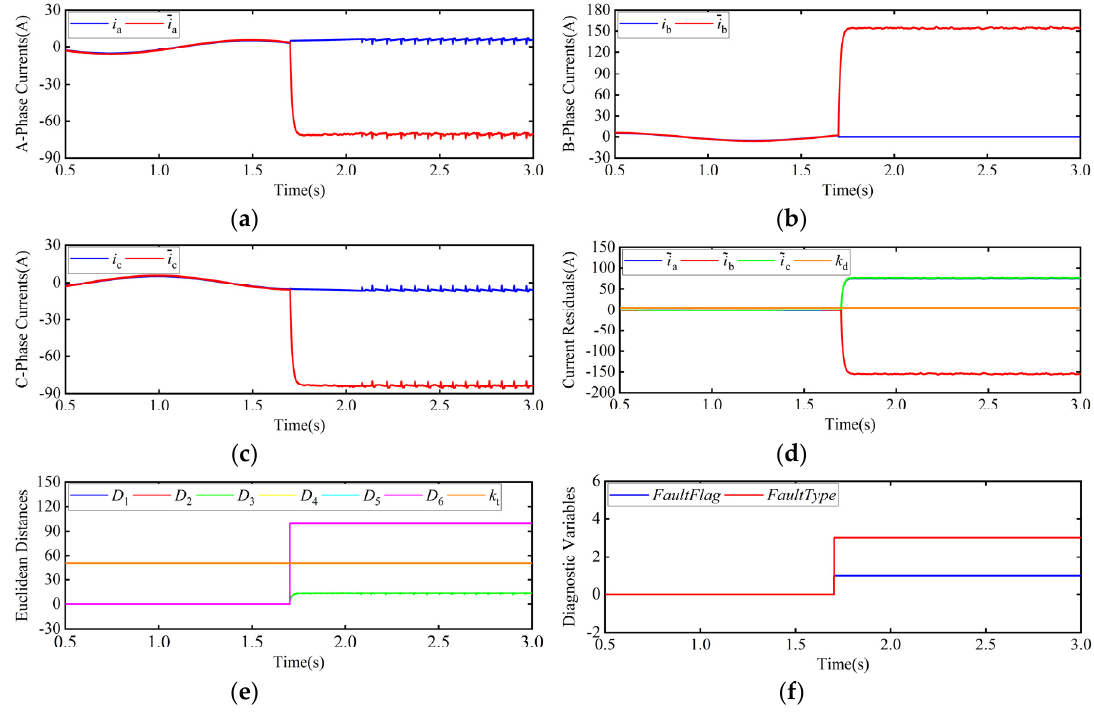
Figure 7. Diagnosis for the OC fault of T 1 under 5 N · m load and for a reference speed of 10 r / min: ( a ) A-phase currents; ( b ) B-phase currents; ( c ) C-phase currents; ( d ) current residuals; ( e ) Euclidean distances; ( f ) diagnostic variables.